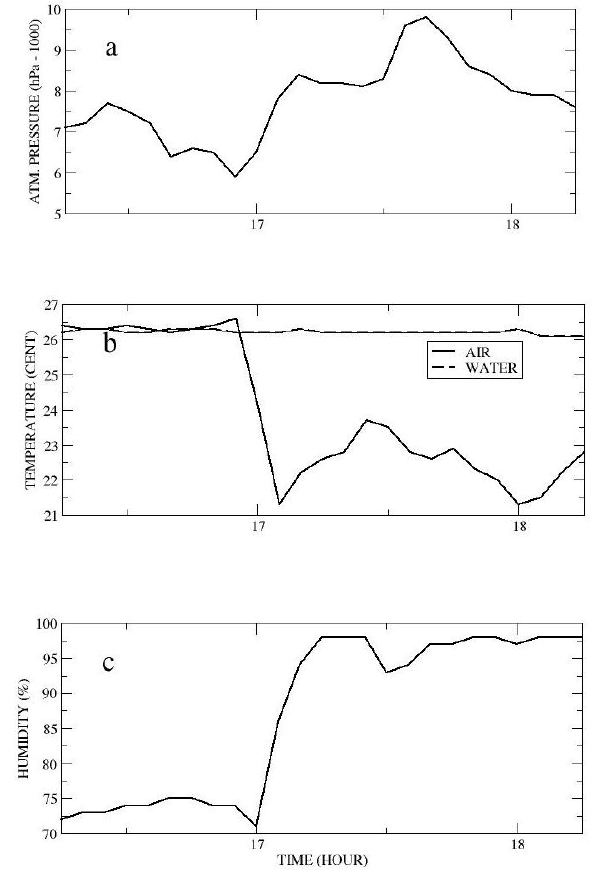
Fig. 7. Time history at the ISMAR oceanographic tower of (a) at- Figure 7 – Time history at the ISMAR oceanographic tower of a) atmospheric pressure, b) air and mospheric pressure, (b) air and water temperature, (c) relative hu- water temperature, c) relative humidity. Time is UTC. midity. Time is